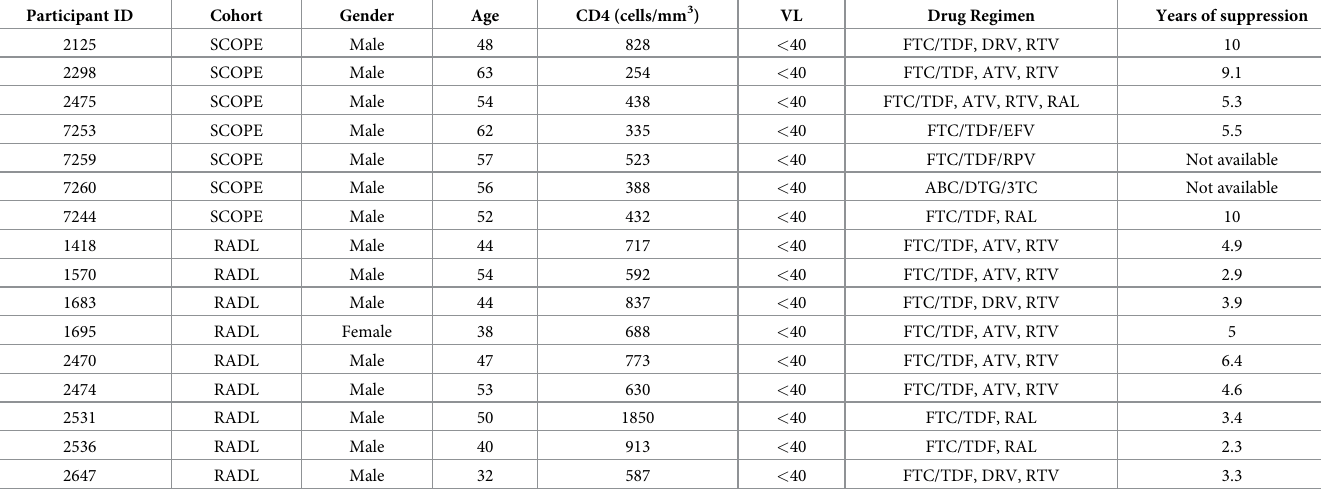
Table 1. Characteristics of HIV-infected study